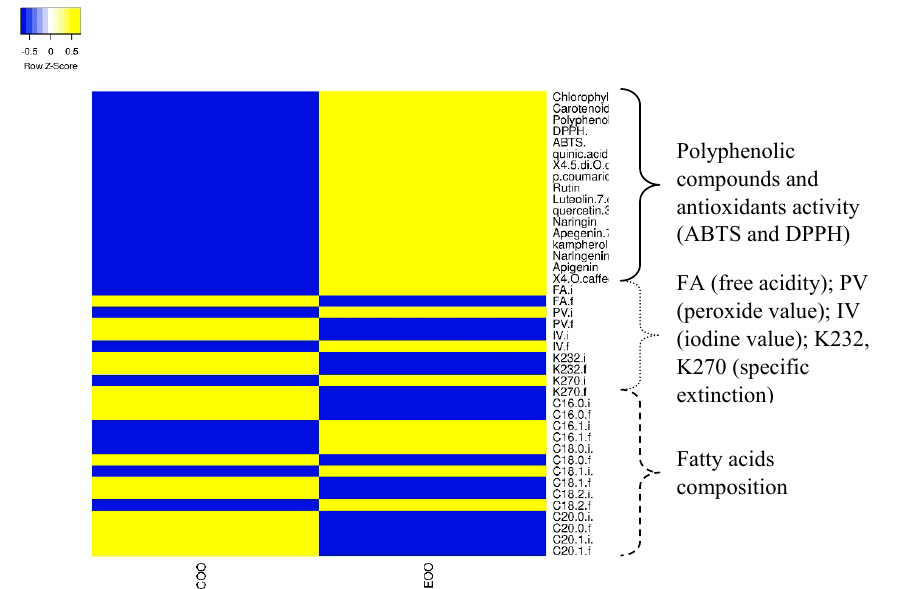
Fig. 1: Heatmap of olive oil parameters, polyphenolic compounds profile, and antioxidants activities (DPPH and ABTS) of the COO and EOO. The mean values refer to colors from the minimum displayed in blue to the maximum represented with yellow (i: initial value before accelerate storage condition; f: final value after accelerate storage